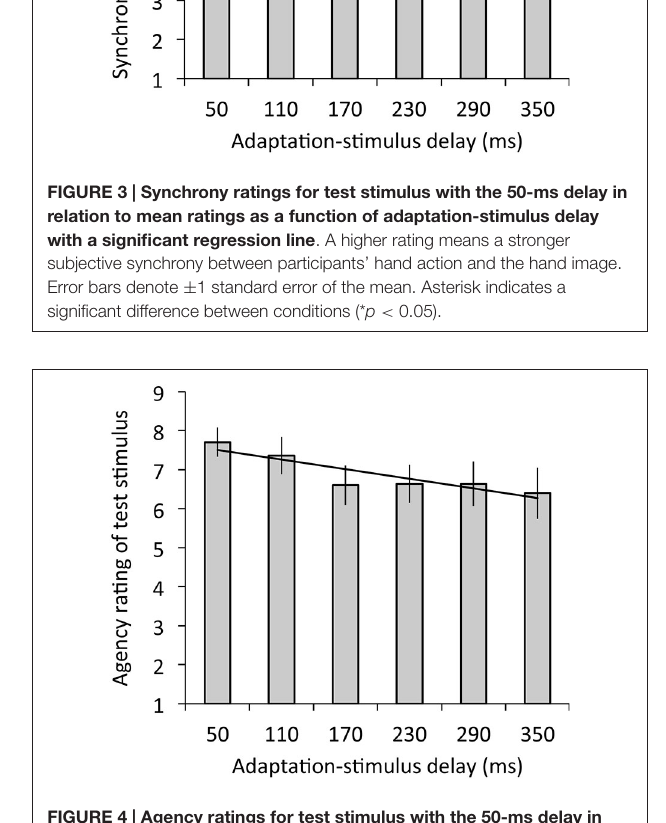
FIGURE 4 | Agency ratings for test stimulus with the 50-ms delay in relation to mean ratings as a function of adaptation-stimulus delay with a significant regression line . A higher rating means a stronger sense of agency over the hand image. Error bars denote ± 1 standard error of the